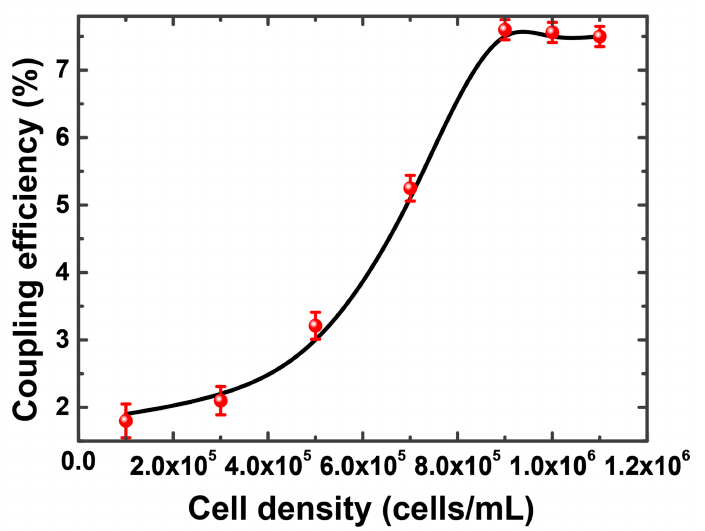
Figure 14. The dependence of the coupling efficiency on the cell density. The measurement was replicated five times, and the error bar represents the standard deviation.